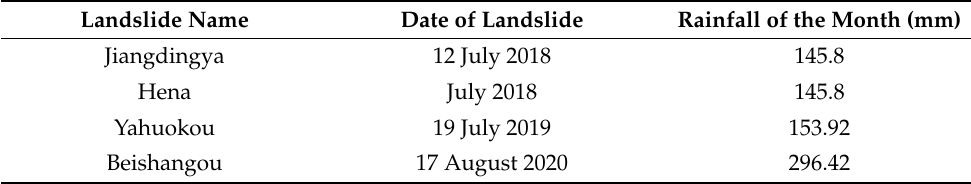
Table 7. Occurrence times and corresponding rainfall totals of relatively large-scale landslides that occurred in Zhouqu in the past 5